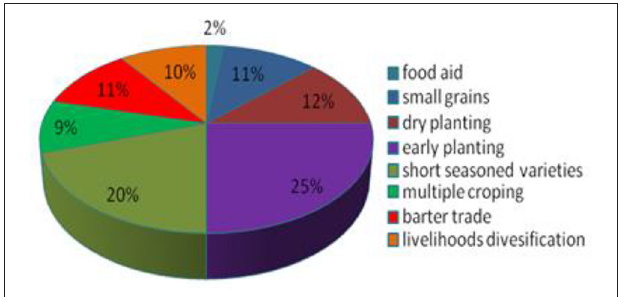
FIGURE 3 | Adaptation strategies (multiple responses) n =